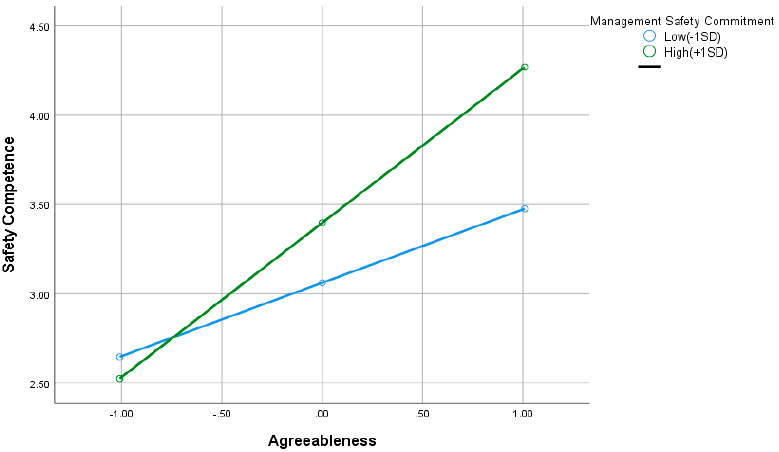
Figure 3. The moderation effect of management safety commitment on the relationship between agreeableness and safety competency.